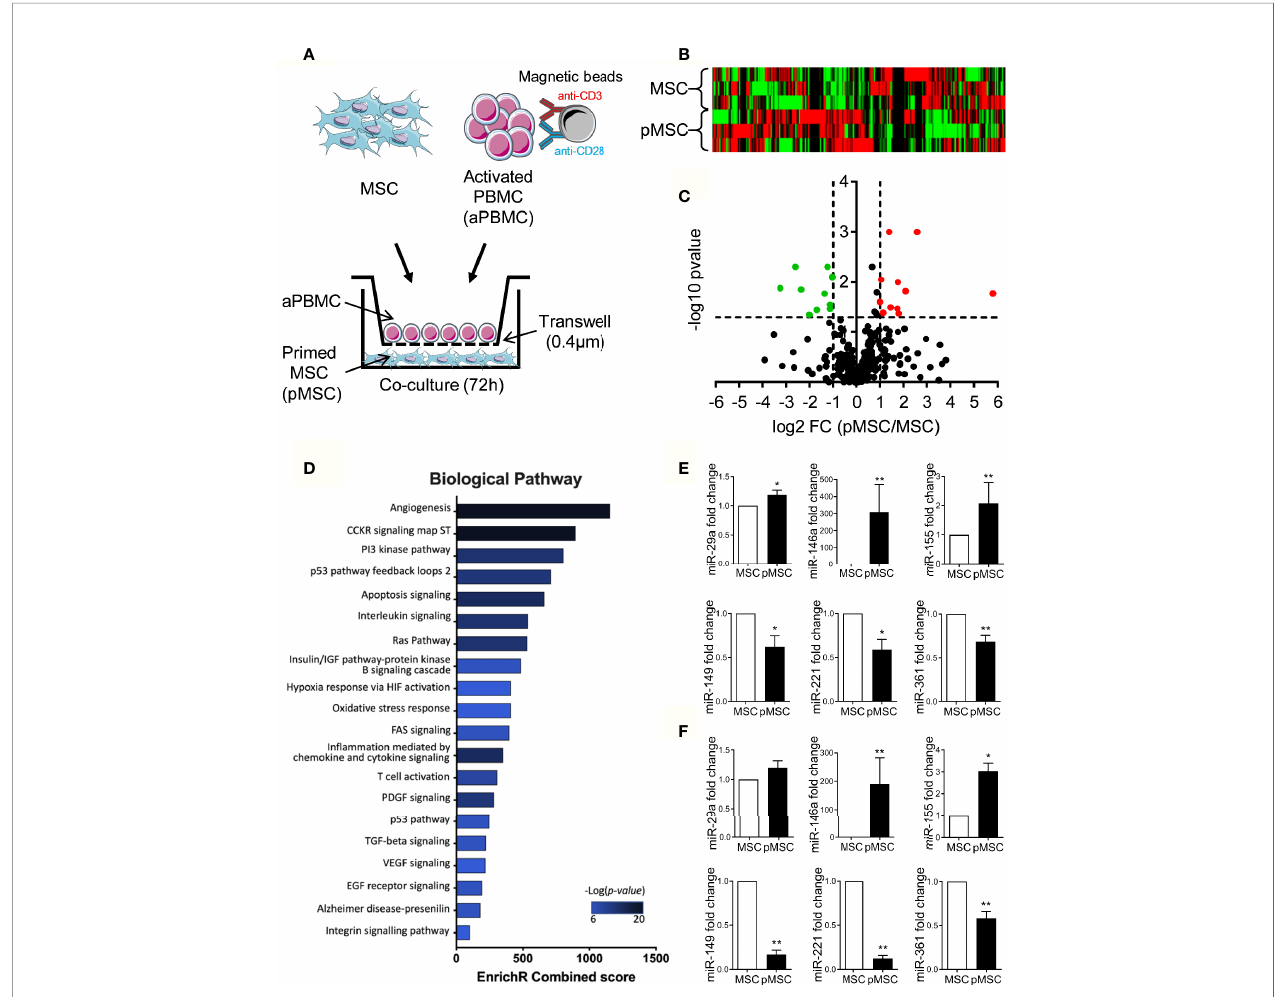
FIGURE 1 | Identi fi cation of several miRNAs modulated in pMSCs. (A) Experimental scheme for miRNA analysis in naïve MSCs and MSCs primed (pMSCs) by activated peripheral blood mononuclear cells (aPBMCs) (n=3 biological replicates). (B) Heat map analysis of naïve MSCs and pMSCs depending on 377 miRNA expression. (C) Volcano plot analysis of miRNAs expressed by naïve MSCs and pMSCs and shown in red for signi fi cantly up-regulated miRNAs and in green for signi fi cantly down-regulated miRNAs. (D) Gene Ontology enrichment analysis of biological pathways for target genes of the top 10 modulated miRNAs (fold change>2.5). (E) Mean fold change ± SEM of six miRNAs selected in (C) in additional samples of naïve MSCs or pMSCs (MSCs + anti-CD3/CD28 antibodies- activated PBMCs) (n=5-9 biological replicates). (F) Mean fold change ± SEM of miRNAs in additional samples of naïve MSCs or pMSCs by PHA-activated PBMCs (n=5-9 biological replicates). Statistical analysis used Wilcoxon matched-pairs Signed Rank Test or paired-t test with *p < 0.05; **p <